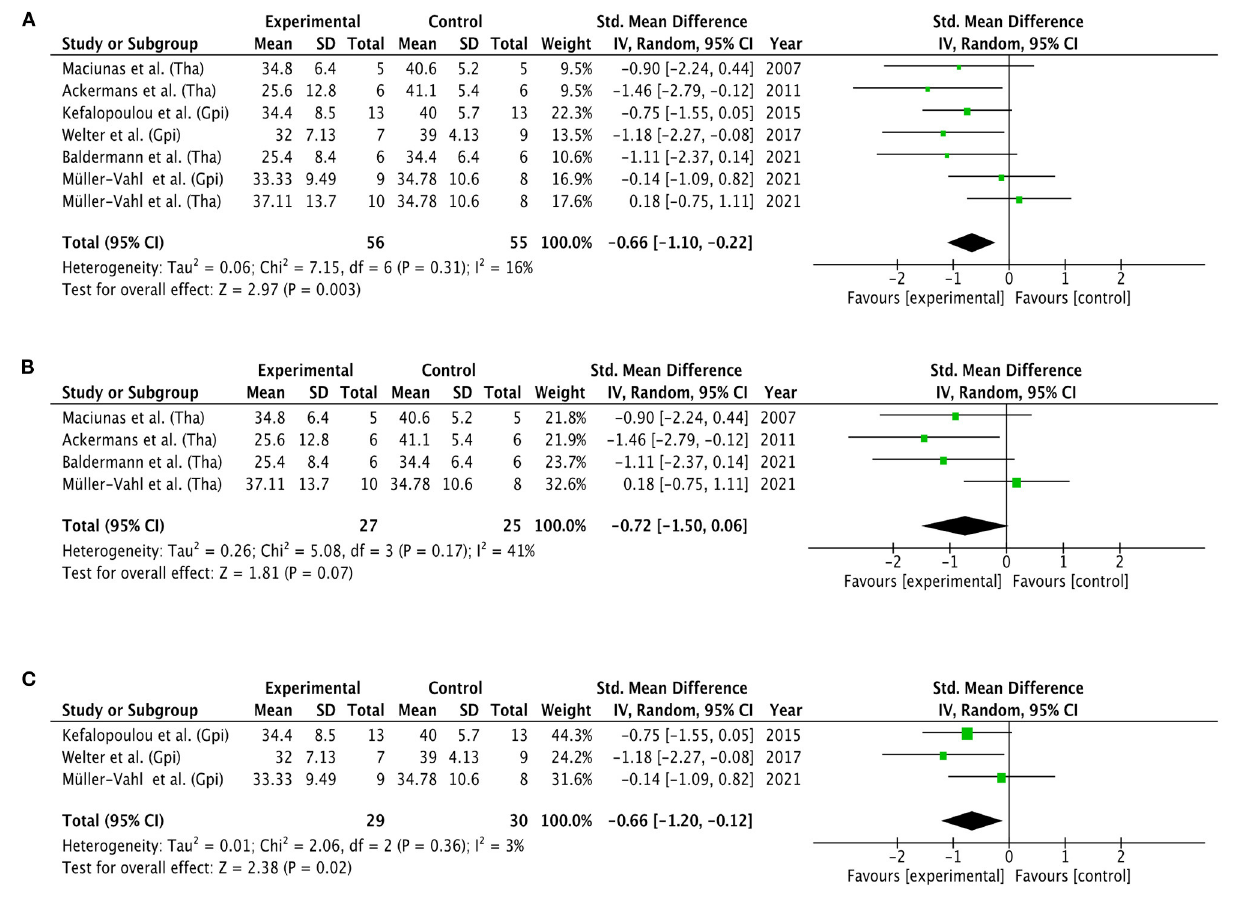
FIGURE 6 | Forest plots of RCTs. Mean YGTSS total tic scores were compared between experimental conditions (DBS ON) vs. control conditions (DBS OFF). (A) General effect of DBS for both thalamic and pallidal targets. (B) Effect of DBS for thalamic targets. (C) Effect of DBS for pallidal targets. Targets were not further specified. Graphics were created with the Review Manager 5.4.1. ( 48). GPi, globus pallidus internus; Tha, thalamus; CI, confidence